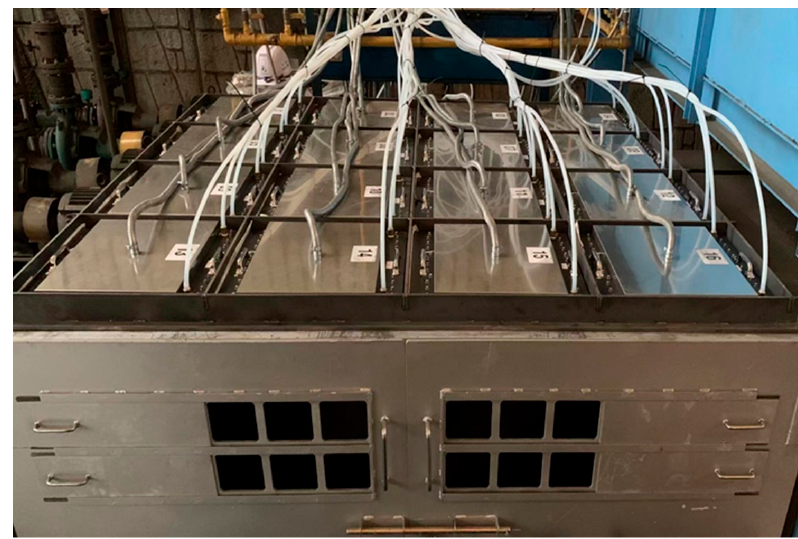
Figure 1. Photograph of WHR system using heat sink-based TEGs.